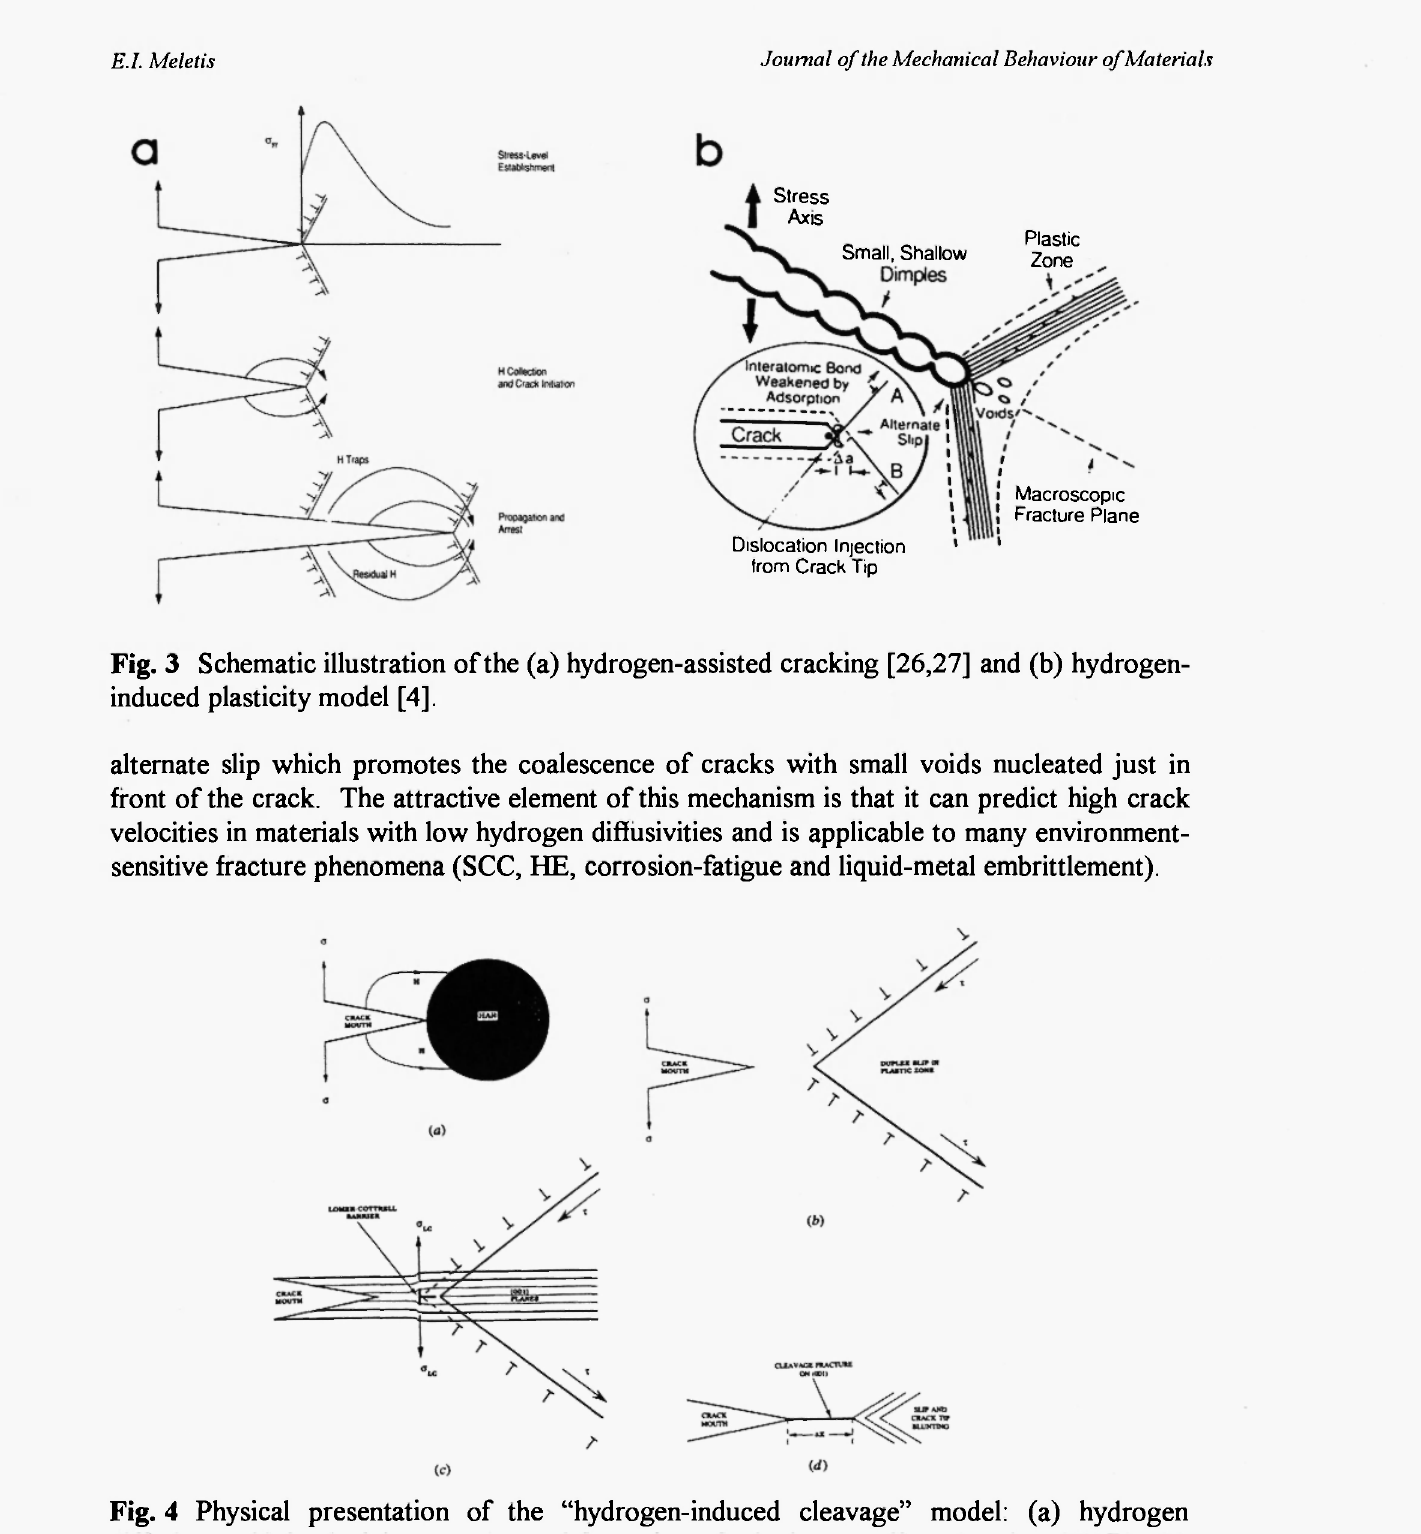
Fig. 4 Physical presentation of the "hydrogen-induced cleavage" model: (a) hydrogen diffusion to high triaxial stress area and formation of a hydrogen-affected region (HAR), (b) slip on intersecting planes within the HAR, (c) dislocation pileup at the LCL and (d) cleavage crack on (001) plane joining up with the main crack